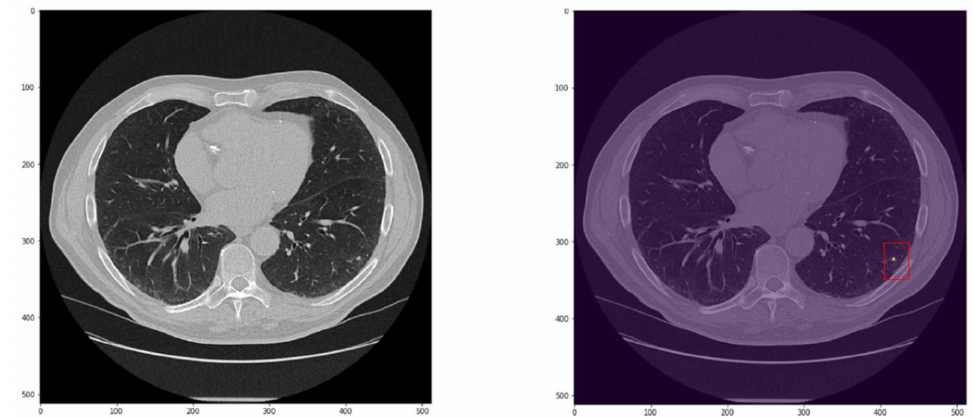
Figure 6. Example of a solid nodule of 6.3 mm (inside the red box) wrongly predicted as benign by the CADx.